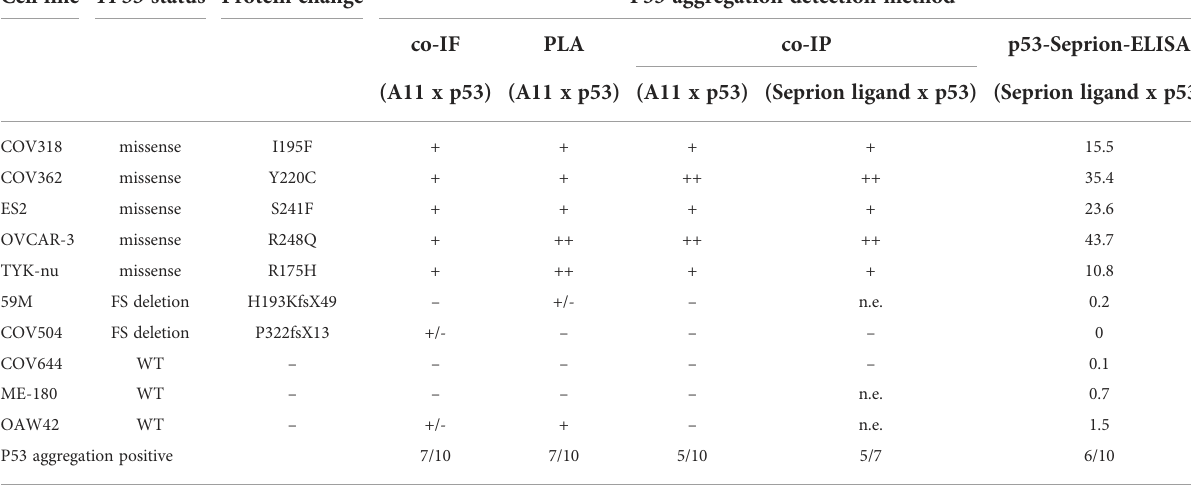
TABLE 1 Comparison of the techniques applied in the detection of p53 aggregates in vitro . Cell line TP53 status Protein